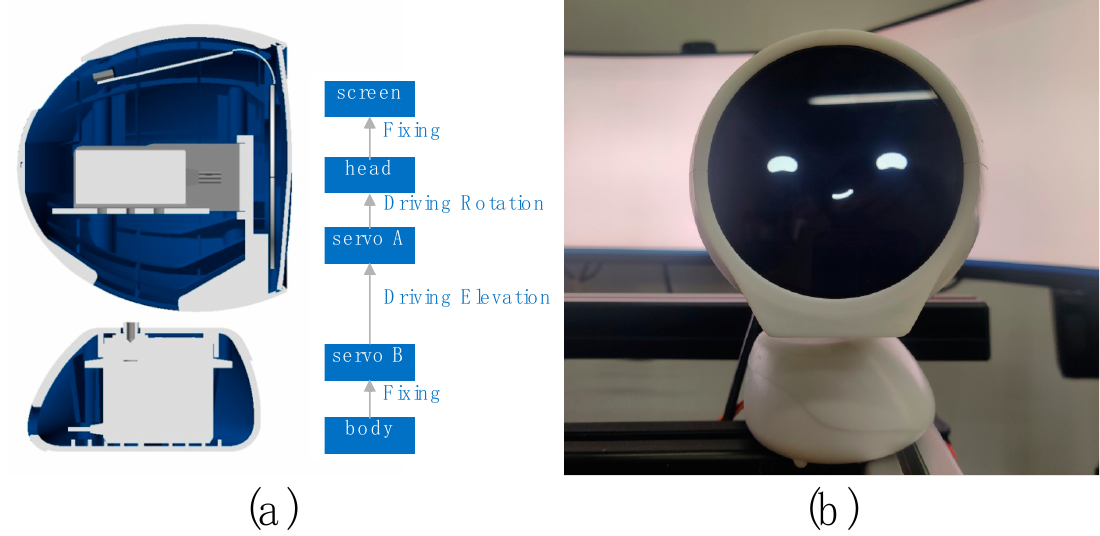
Figure 7. ( a ) Structure of “XiaoV”. ( b ) Appearance of “XiaoV”.